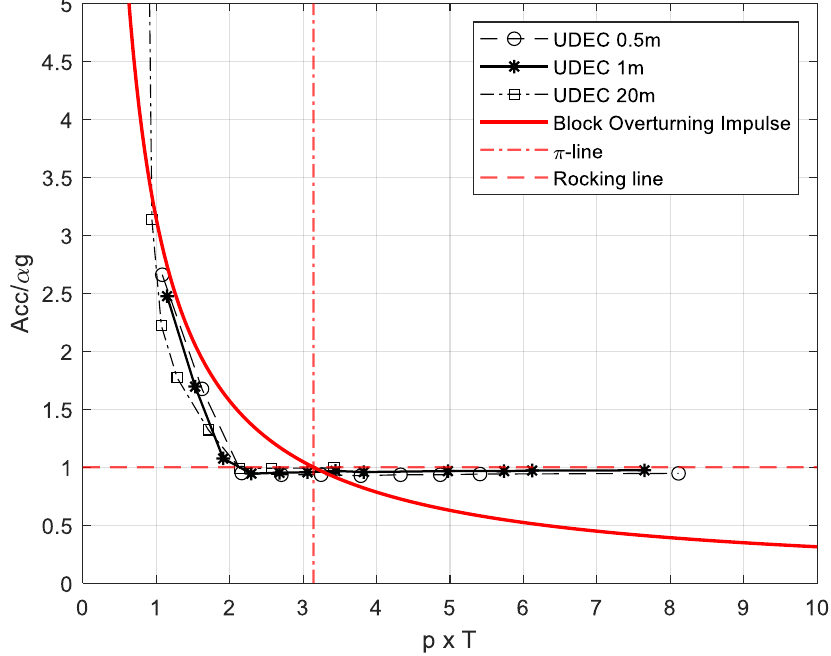
Figure 4. Normalized numerical results for all three block sizes under harmonic pulses.